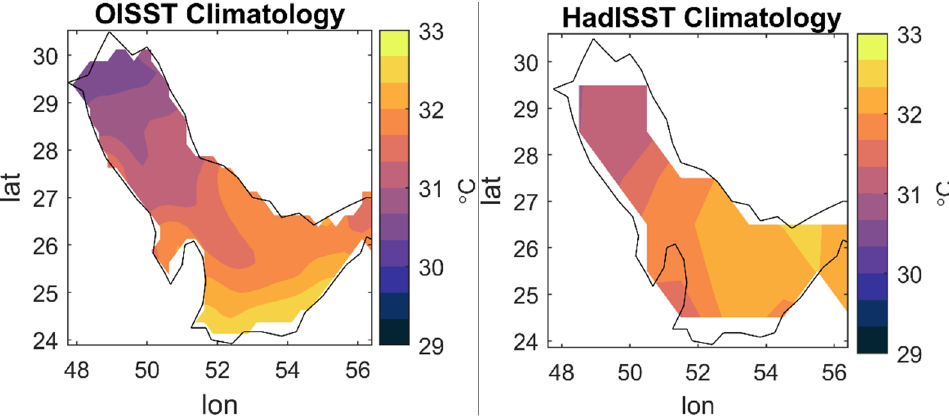
Figure 3. Summer climatology of the OISST and HadISST (1982–2018).